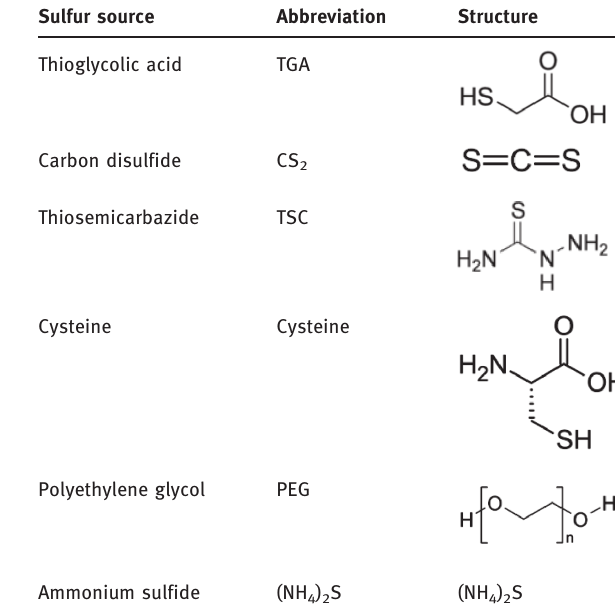
Figure 9: SEM image of sample no. 1.